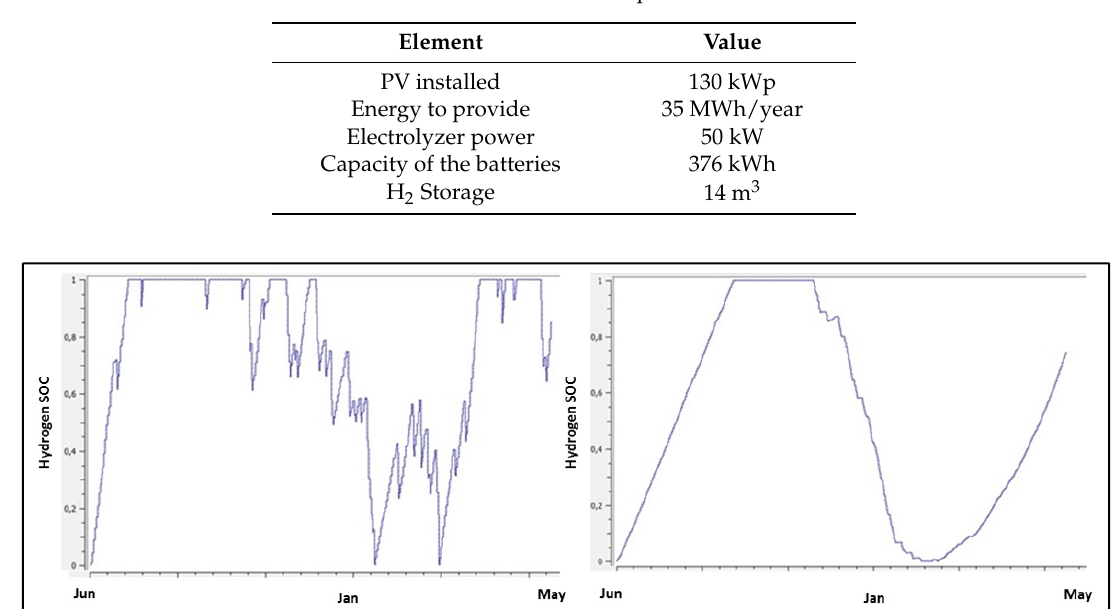
Figure 8. Evolution of H 2 state of charge in Tenerife and Edinburgh.